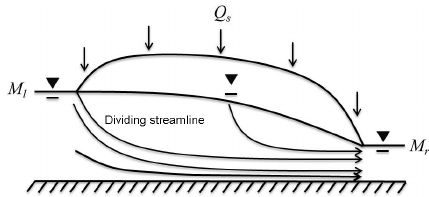
Figure 5. Schematic of a simple profile with Dirichlet boundary conditions on the right and left (M r ,M l ) , a constant source ( Q s ), and steady-state, variably saturated groundwater flow. Note the di- viding streamline in this example. In the theory, the vertical and horizontal extents of the cross section are assumed to be constant.